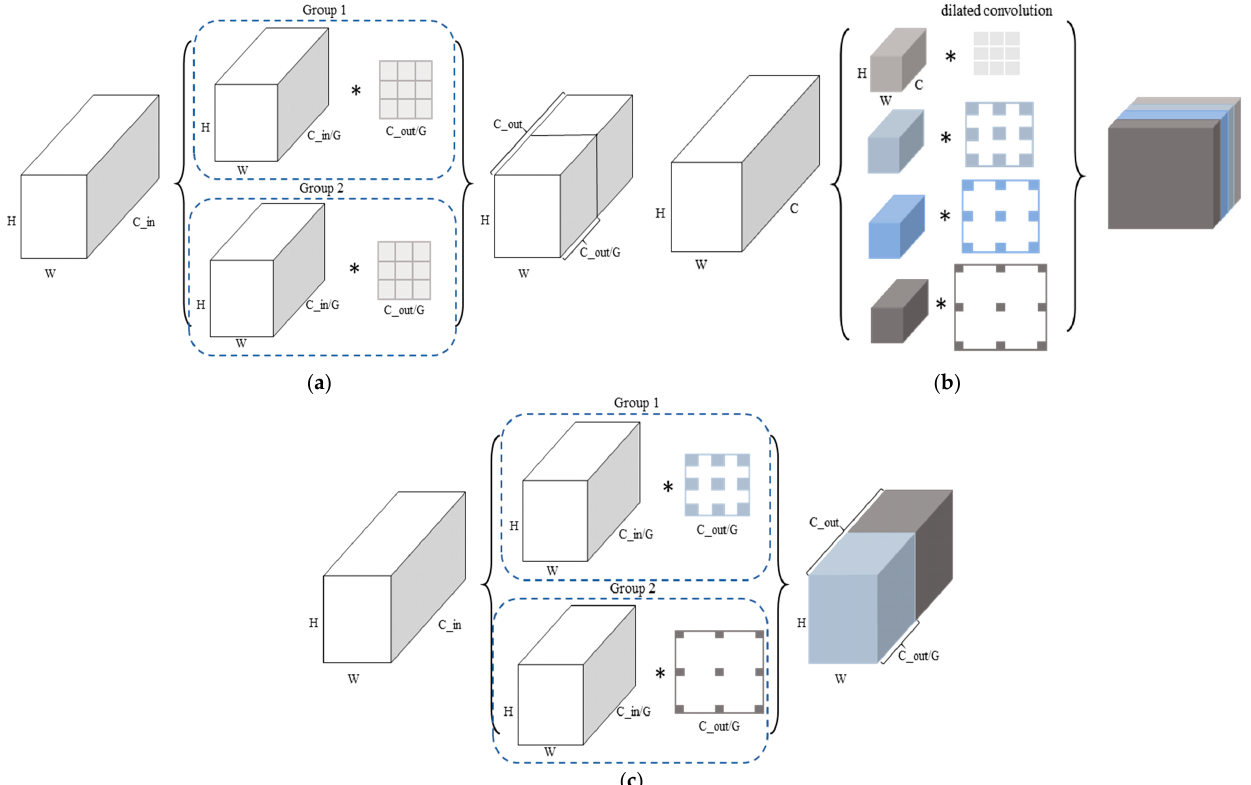
Figure 2. Examples of each method: ( a ) grouped convolutions when G is two; ( b ) atrous pyramid pooling based on dilated convolutions among spatial pyramid pooling techniques; ( c ) structure of the proposed GDCM. * means convolution operation.